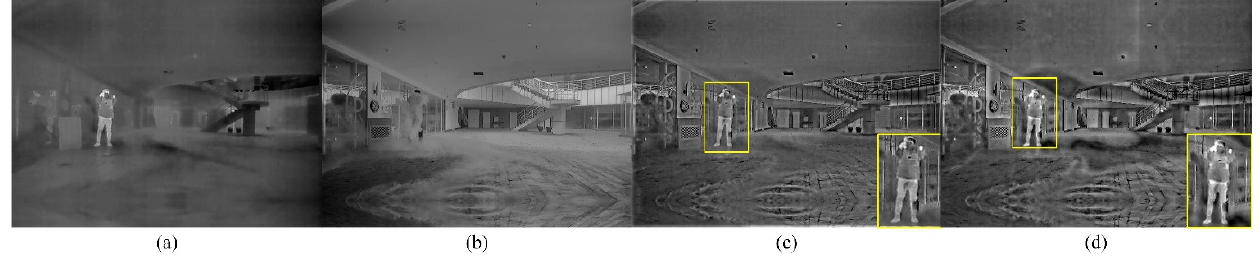
Figure 11. Test result in the smoke scene. ( a ) Infrared image; ( b ) Visible image; ( c ) Fused image on FPGA; ( d ) Fused image on PC. FPGA; ( d ) Fused image on